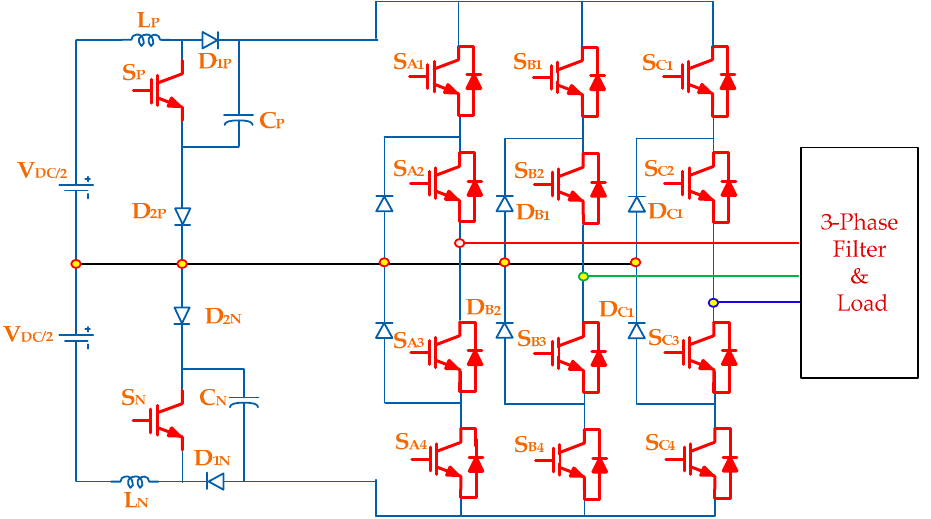
Figure 29. Three level LC-switching voltage boost NPC inverter.